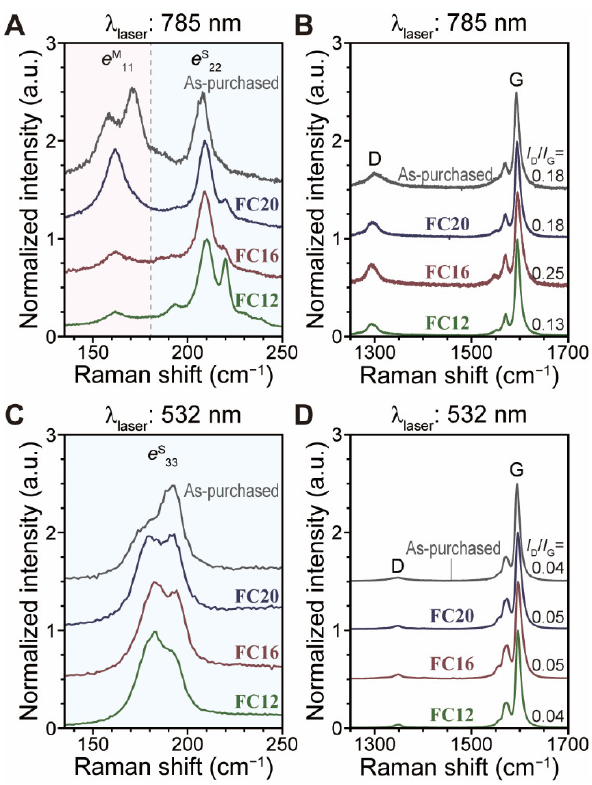
Figure 5. Raman spectrum changes of PSWNT with centrifugation of 5 k g with varying l S of flavin. ( A ) RBM and ( B ) G band spectra excited by a 785-nm laser. As-purchased PSWNT was used as a control. The dispersions were deposited on a 285-nm-thick SiO 2 /Si substrate and were washed with copious amount of acetone to remove flavins. The corresponding ( C ) RBM and ( D ) G band spectra of the sample excited by a 532-nm laser.